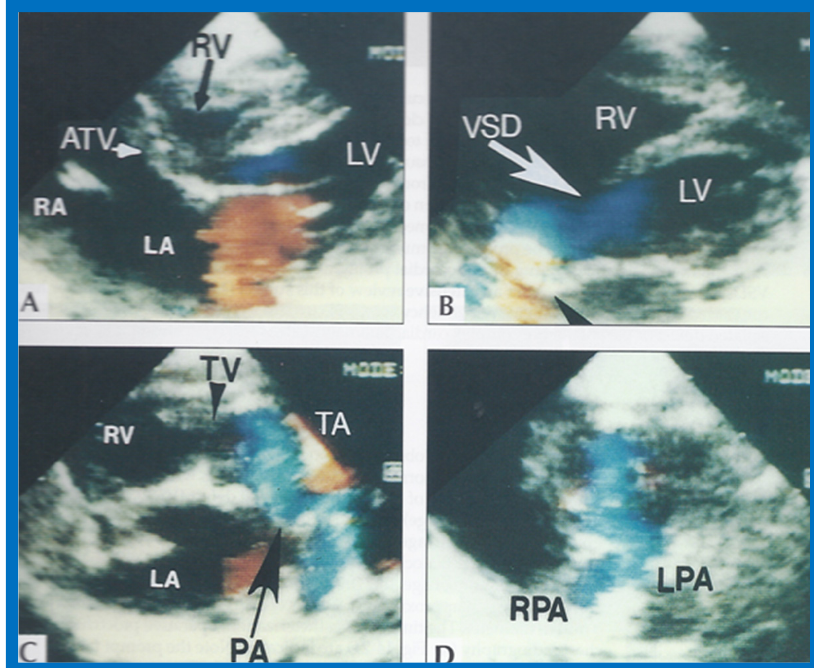
Figure 24. Video frame from a two ‐ dimensional echocardiographic and color Doppler study demonstrating ( A ) atretic tricuspid valve (ATV) between the right atrium (RA) and right ventricle (RV) and blood flow from the left atrium (LA) into the left ventricle (LV) across the mitral valve. The RV (arrow) is very small and hypoplastic. ( B ) LV and RV with a large ventricular septal defect (VSD) below the truncus arteriosus (TA). Turbulent flow across the truncal valve suggests truncal valve stenosis. ( C ) origin of the pulmonary artery (PA) from the TA by color flow (arrow), and ( D ) division of right (RPA) and left (LPA) pulmonary arteries from the PA (labeled in d) in a short ‐ axis view. TV, truncal valve leaflets. Reproduced from Rao P.S., et al. [22].